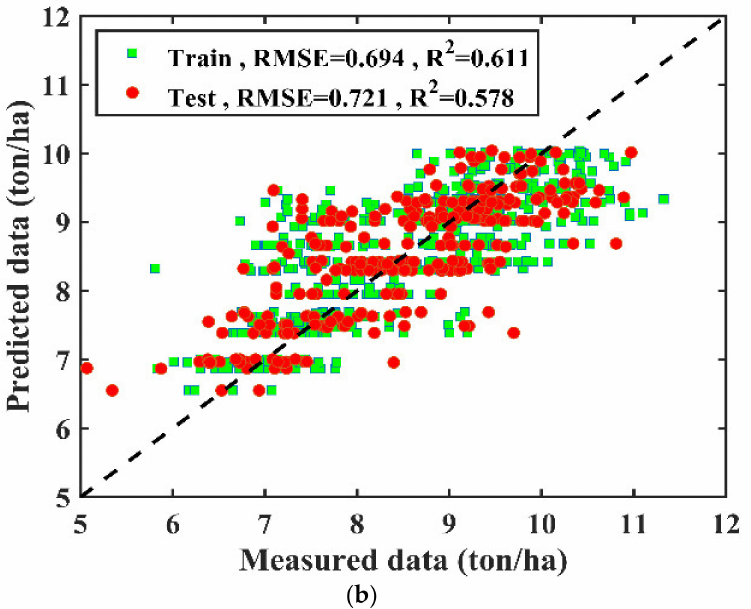
Figure 3. ( a ) Performance of partial least squares regression (PLSR) model with optimized PLS factor of 2 for training and testing sets using climate data; ( b ) performance of feed-forward backpropagation neural network (FFBN) model with optimized number of neurons of 13 in the hidden layer for training and testing sets using climate data.